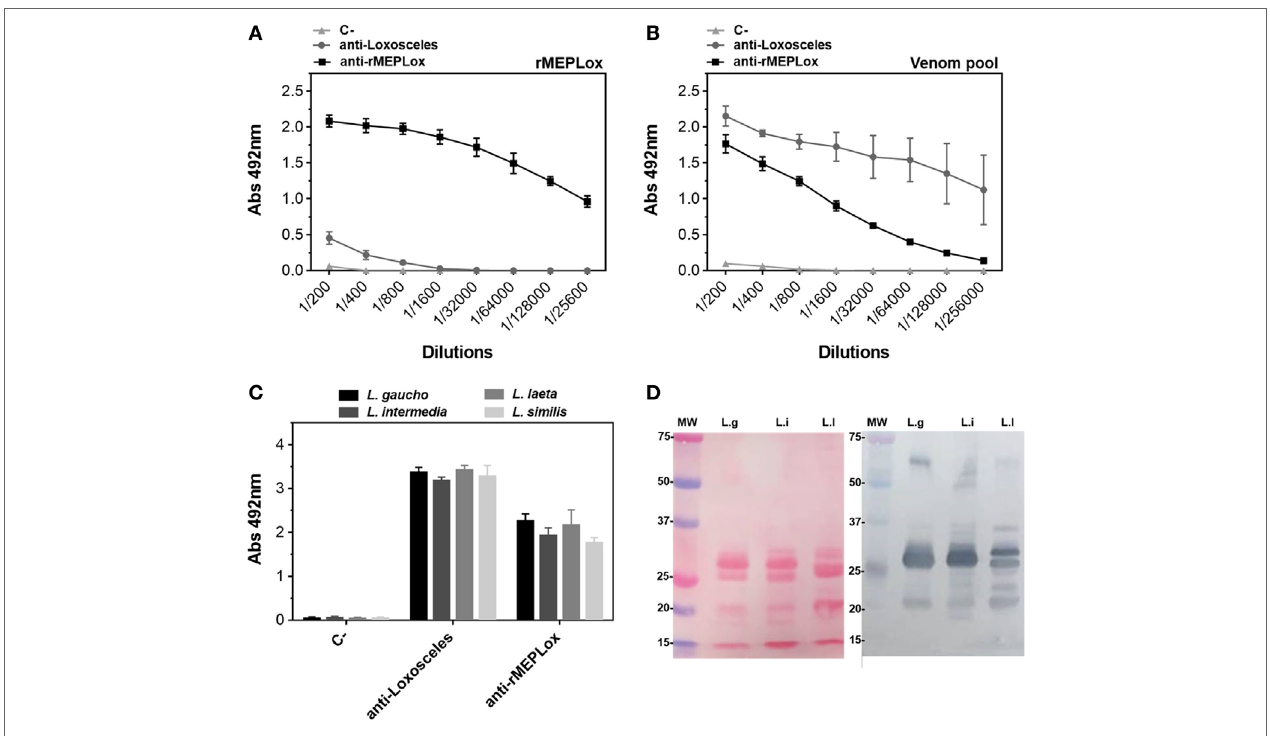
FigUre 7 | Immunoreactivity of anti-rMEPLox sera by ELISA. Plates were coated with either rMEPLox, a pool or individual Loxosceles venoms (5 µg/mL) and sera from rabbits immunized either with rMEPLox, a pool of Loxosceles venoms or only adjuvant were assayed by ELISA and values given are the means of duplicates. Samples absorbance was determined at 490 nm. (a) Reaction of rMEPLox with the tested sera, in serial dilution. (B) Reaction of coated pool of Loxosceles venoms with the tested sera, in serial dilution. (c) Reaction of coated individual loxoscelic venoms with the tested sera, in 1/400 dilution. Sera were tested by ELISA and values given are the means of trplicates. (D) At the left panel (Ponceau), the figure shows the profile of the transferred proteins. At the right panel, western blotting of loxoscelic venoms [ L. gaucho (L.g); L. intermedia (L.i); and Loxosceles laeta (Ll)] probed with anti-rMEPLox rabbit sera 1/1,000